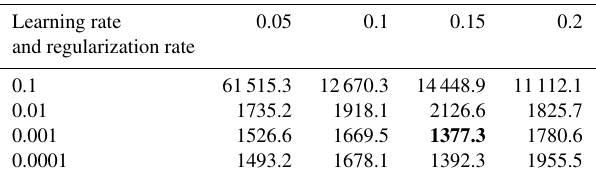
Figure 3. (a) Actual detection signal. (b) Inversion of theoretical detection signal. Table 1. The training cost of the combination of learning rate and regularization rate. The value represents the MAE of the first 50 data points. Based on experience, about the first 50 data points have a better effect for extracting time-domain order waveforms. The best combination result of the learning rate and the regularization rate is the smallest value, which is shown in